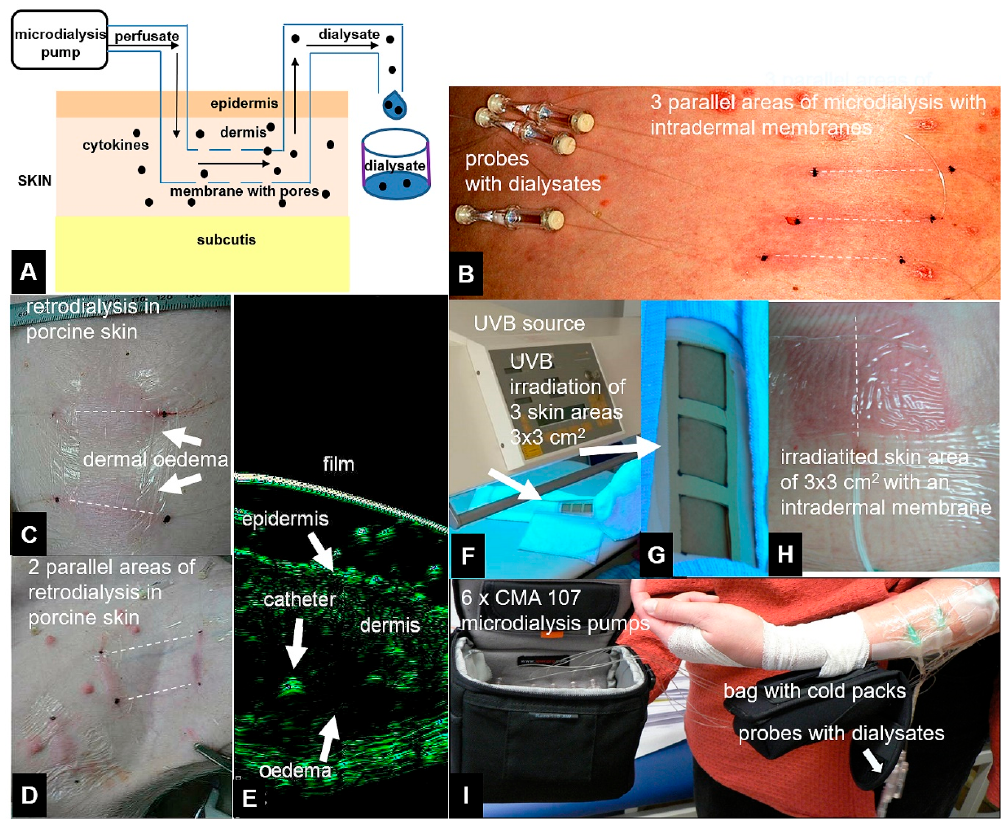
Figure 1. Principle of the microdialysis experiments: 100 kDa cut-off membranes perfused with crystalloid or colloid solutions (perfusates) were placed in the dermal skin using a microdialysis pump at flow rates of 0.2, 0.5, or 1 µL/min. The dialysates were collected in fractions after an exchange process within dermal skin between the interstitial fluid and the perfusate via a microdialysis membrane (scheme, A ). Clinical pictures of linear microdialysis cut-off membranes (CMA) 66 catheters placed in human skin ( B ). Retrodialysis of porcine skin indicated cytokine release from the catheter to the dermis. Signs of inflammation in the catheter areas included rubor and tumefaction ( C , D ) as well as dermal oedema surrounding the microdialysis catheter ( E ), as demonstrated by high-resolution 22 MHz ultrasound (Taberna Pro Medicum, Luneburg, Germany). After placement of the microdialysis catheters into the dermal skin of a human forearm, UV irradiation and skin erythema were used to generate cytokines and chemokines ( F – H ). Dialysates were collected for 48 h after UVB irradiation in this clinical experiment ( I) . Dotted lines indicate virtual intradermal placement of microdialysis membranes.